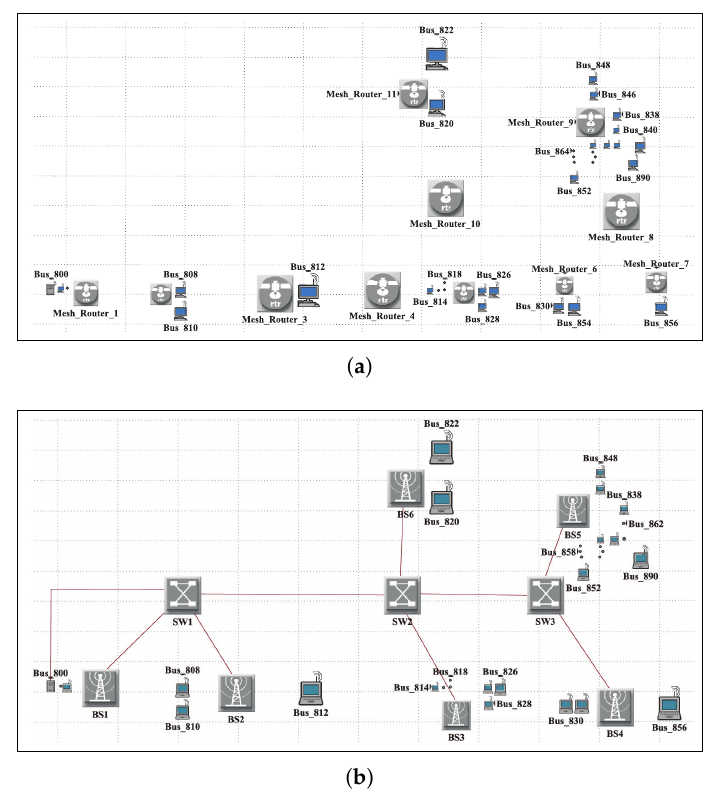
Figure 7. The modeled network topologies of 13 Node. ( a ) 13 Node WLAN Mesh; ( b ) 13 Node WLAN WiMax.